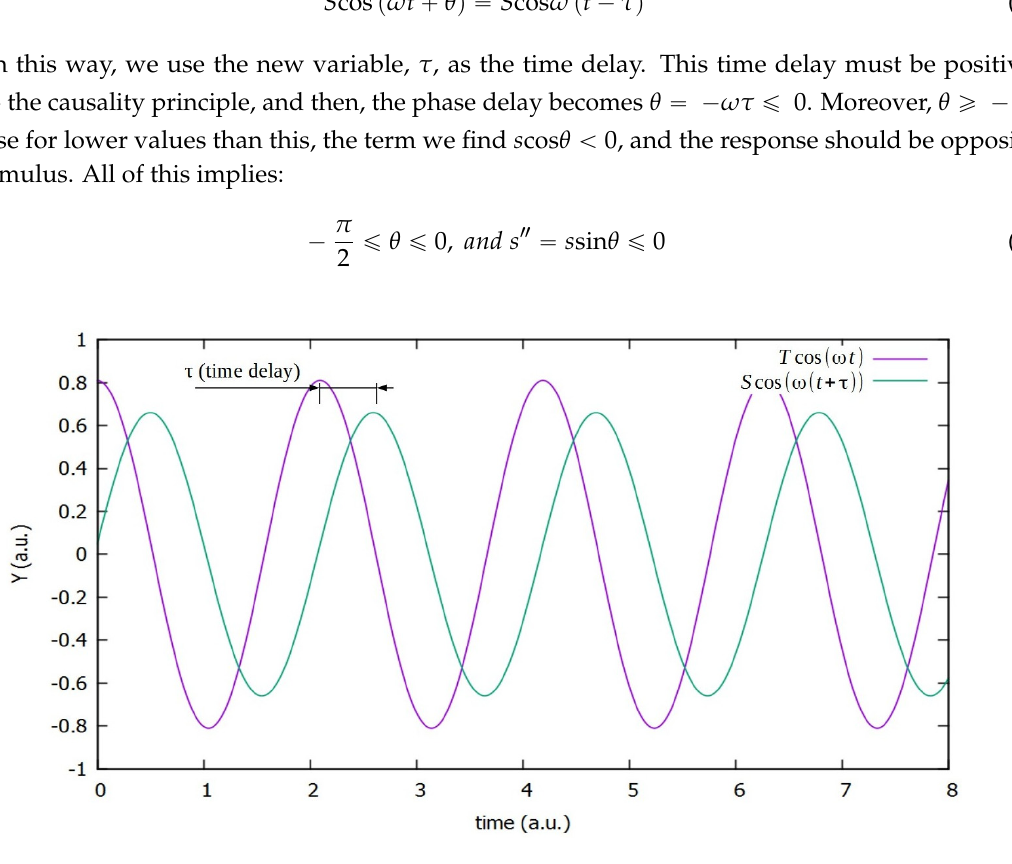
Figure 1. Single harmonic signal and delayed or lossy response.